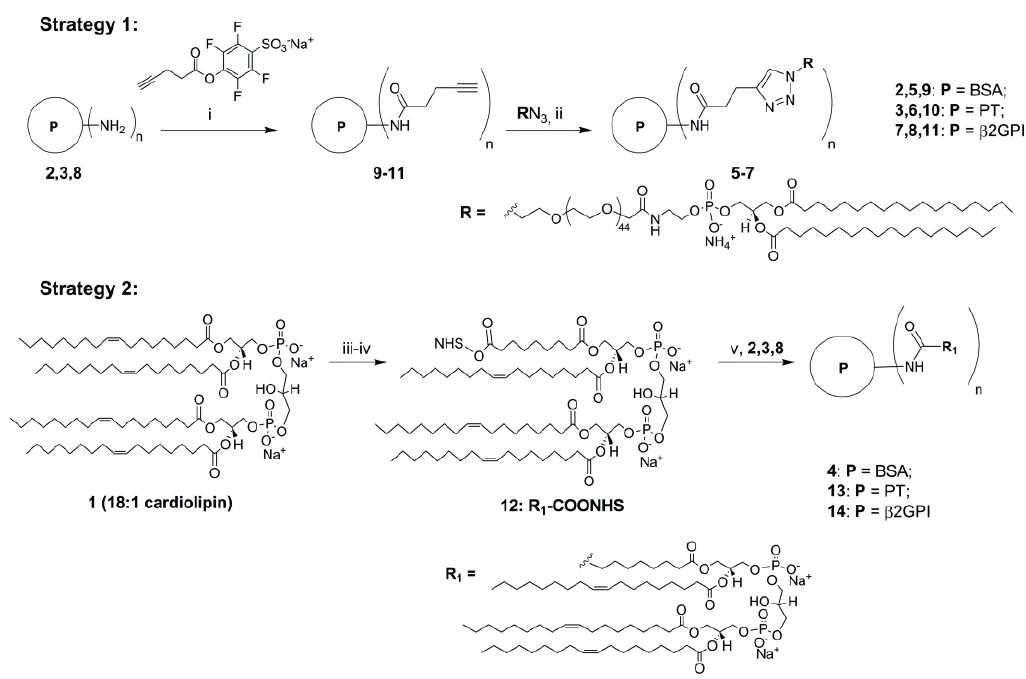
Scheme 1. Synthesis of new phospholipid-protein conjugates by amide coupling and